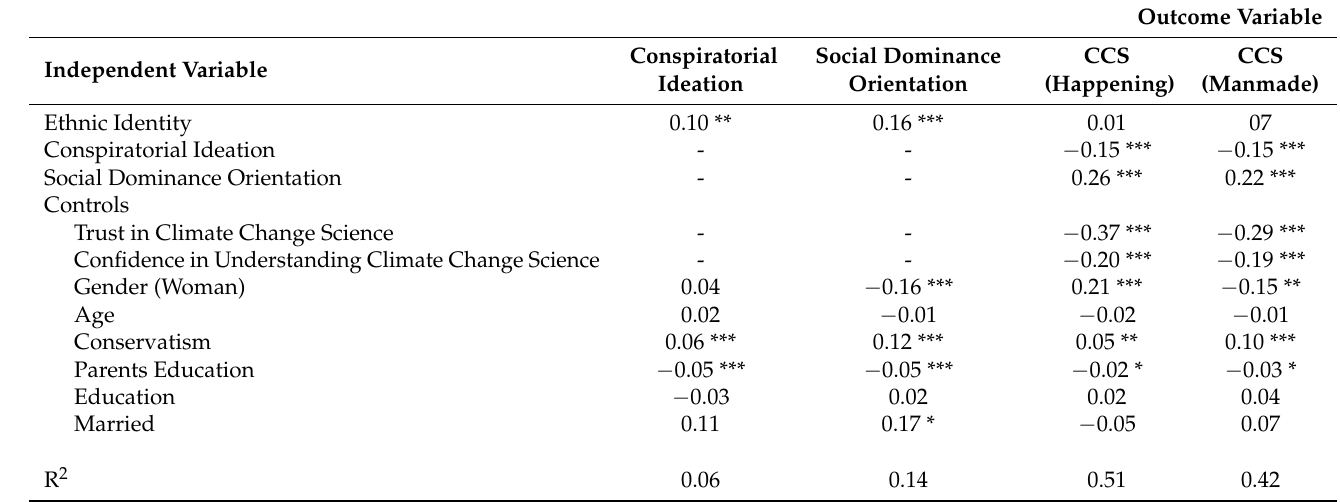
Table 3. Unstandardized Coefficients of Seemingly Unrelated Regression: Ethnic